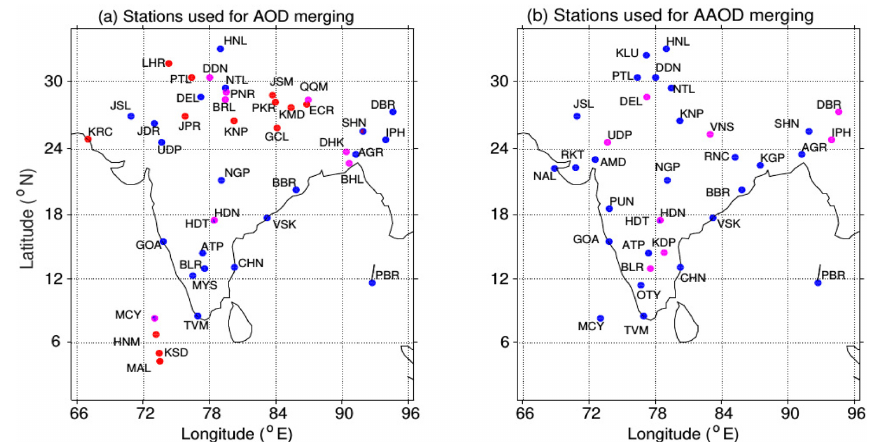
Figure 1. Locations of the ground-based stations, AODs (a) and BC (surface-level) mass concentration measurements (b) which are used in the present study. In panel (a) , blue and red dots represent, respectively, the ARFINET and the AERONET stations, the AODs from which are assimilated, while the pink dots represent the stations, the data from which are used for independent validation (and not used in the assimilation). In panel (b) , blue and pink dots denote the ARFINET stations providing BC data for assimilation and validation, respectively.